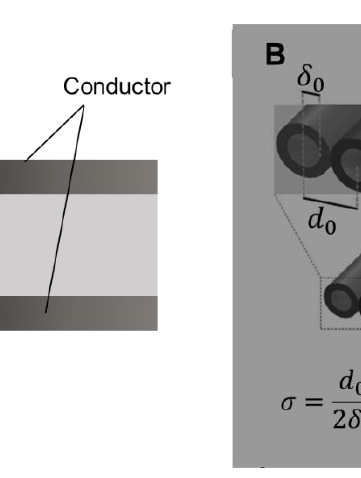
Figure 8. Working principle of capacitive sensor. ( A ) Illustration of capacitor: s is the facing area and d is the vertical distance. ( B ) Stretchable capacitive sensors with double helix liquid metal fibers, reproduced with permission from [114].